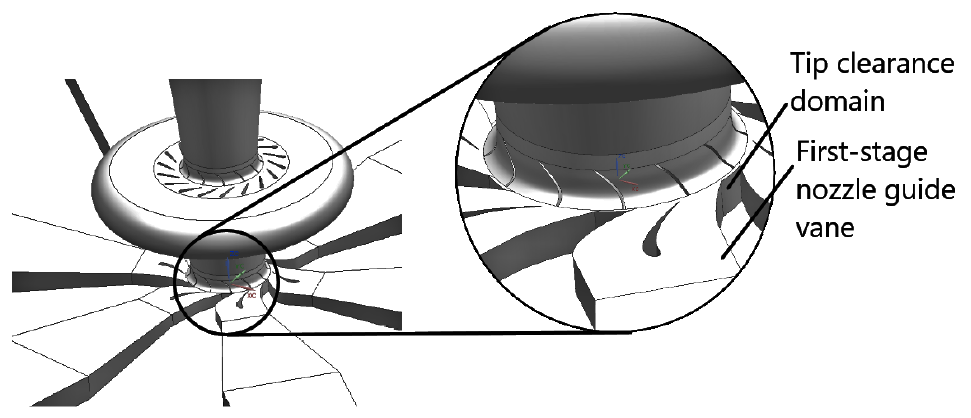
Figure 3. Computational domain set-up: ( a ) isometric view with 6 exhaust pipes; ( b ) cross-Section of the first and second- stage; ( c ) close-up at the clearance gap domain.